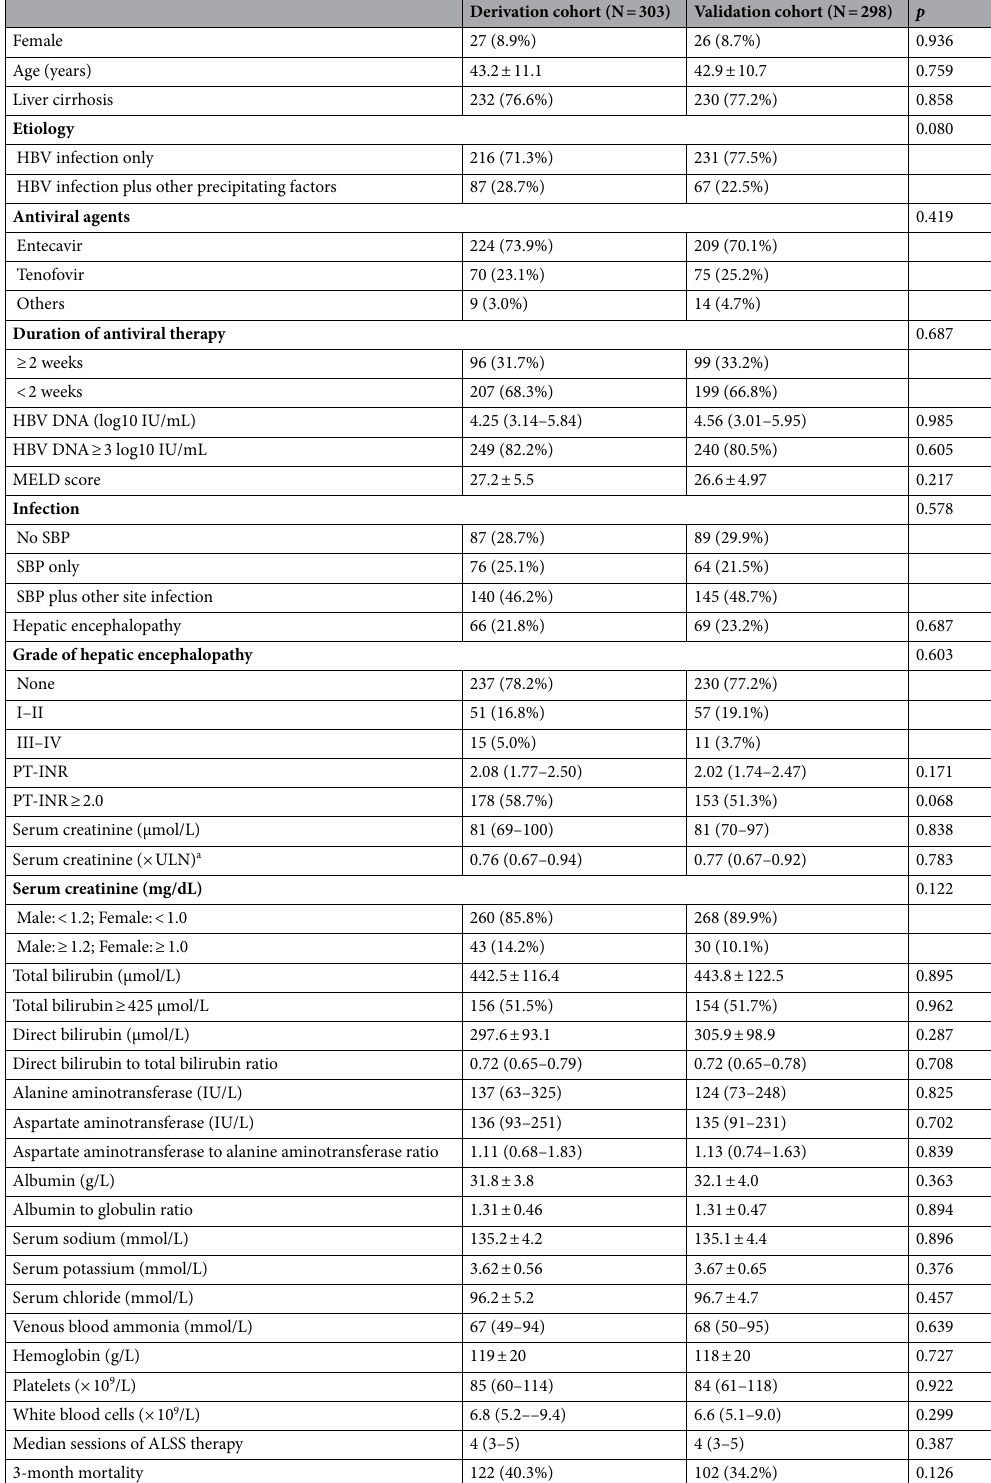
Table 1. Characteristics of derivation and validation cohorts. HBV hepatitis B virus, ACLF , acute-on- chronic liver failure, MELD model for end-stage liver disease, SBP spontaneous bacterial peritonitis, PT-INR international normalized ratio (INR) of prothrombin time (PT), ULN upper limit of normal, ALSS artificial liver support system. a Serum creatinine (× ULN) equals to serum creatinine (μmol/L) divided by the upper limit of normal (Male: 106 μmol/L; Female: 88 μmol/L). Measurement data are represented as mean ± SD (Normally distributed data) or median (P25–P75) (Non-normally distributed data). Enumeration data are represented as frequencies